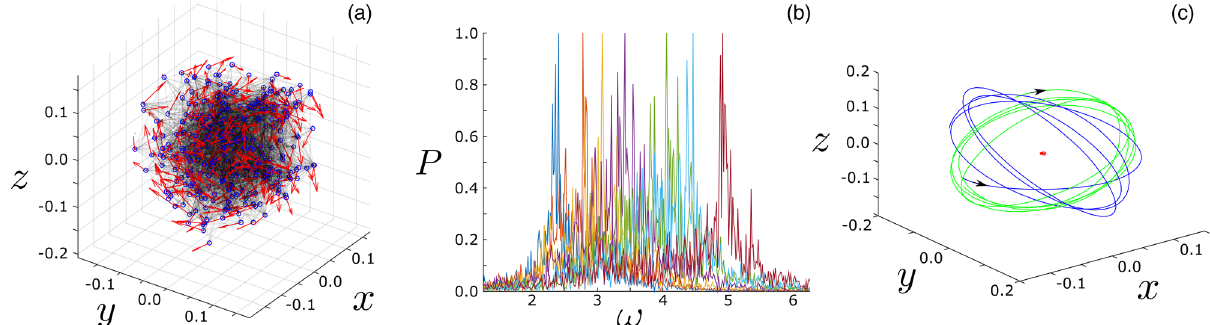
Figure 1. Milling state in self-propelled swarming networks. ( a ) Snap-shot of milling in which agents are drawn with blue circles, velocities with red arrows, and network edges with black-lines. ( b ) The Fourier spectra (normalized, absolute value) of seven randomly selected agents drawn with different colors. For reference, the leftmost spectrum corresponds to a k = 8 agent while the rightmost corresponds to k = 40 . ( c ) Trajectory of a k = 10 agent (blue), k = 20 agent (green), and the swarm center of mass (red). The network topology was a Waxman geometric random graph with 300 agents and an average degree of 20. Other model parameters are: α = 1 , β = 5 , l 1 = 0.1 , l 2 = 1 , and (cid:31) = 2 .